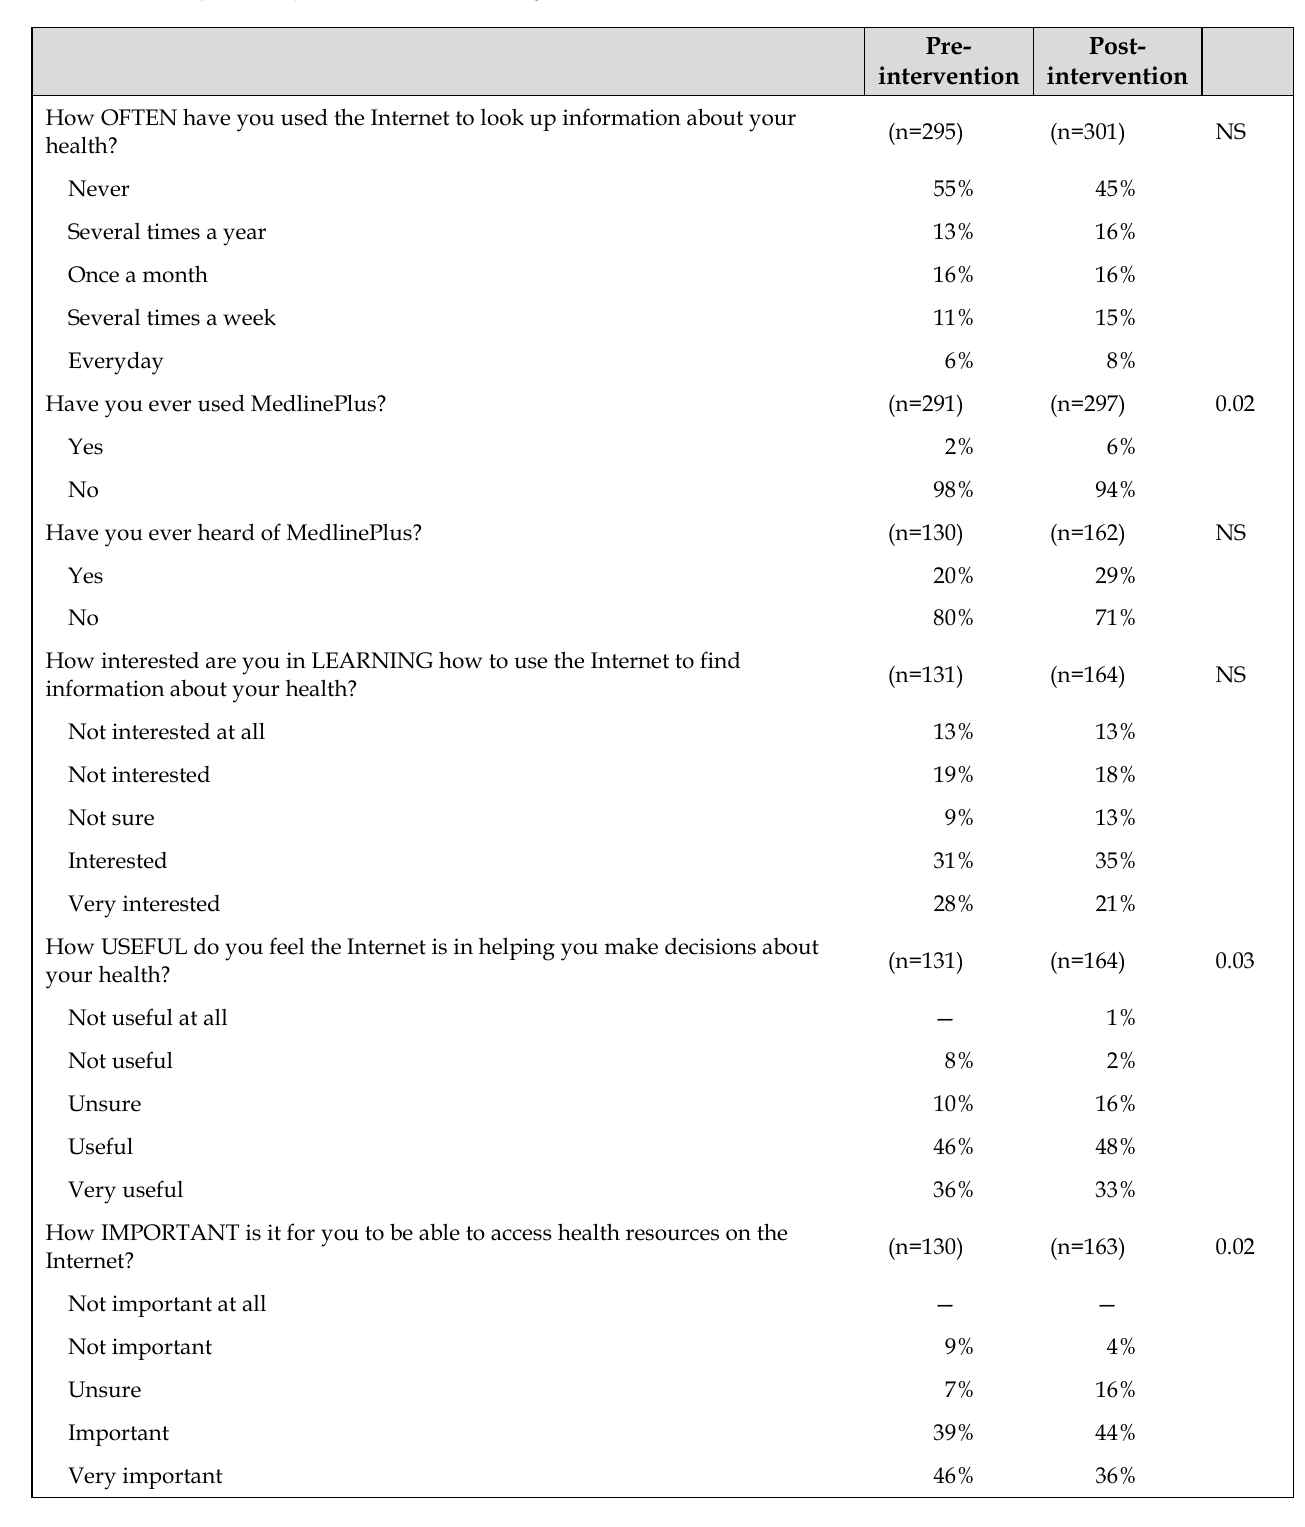
Table 3 Patient pre- and post-intervention survey results